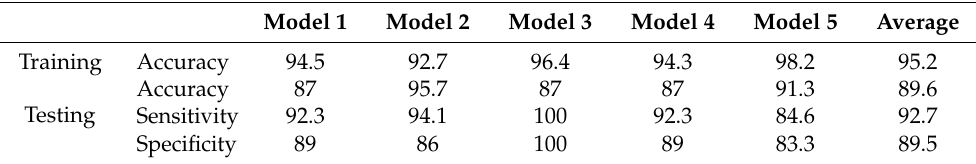
Table 4. Model performance